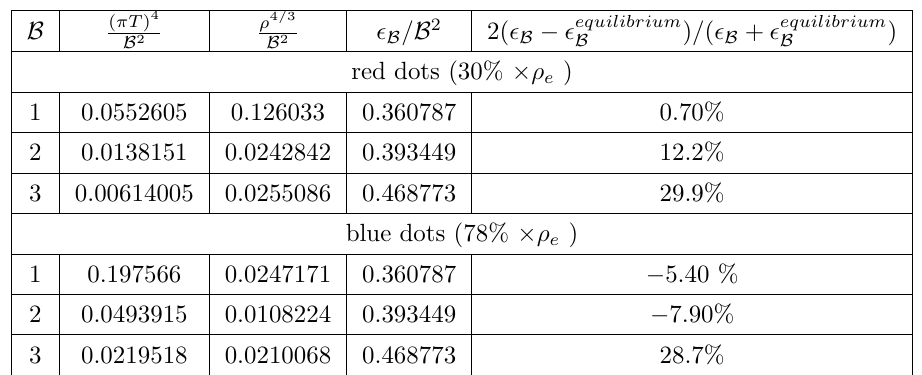
Comparison to equilibrium data: last column shows deviation (in percent) between 2 and that of the equilibrium solutions, i.e. the charged magnetic our late time energy density (cid:31) / B B black brane solutions. These data points are displayed in figure 4 as red and blue large dots.